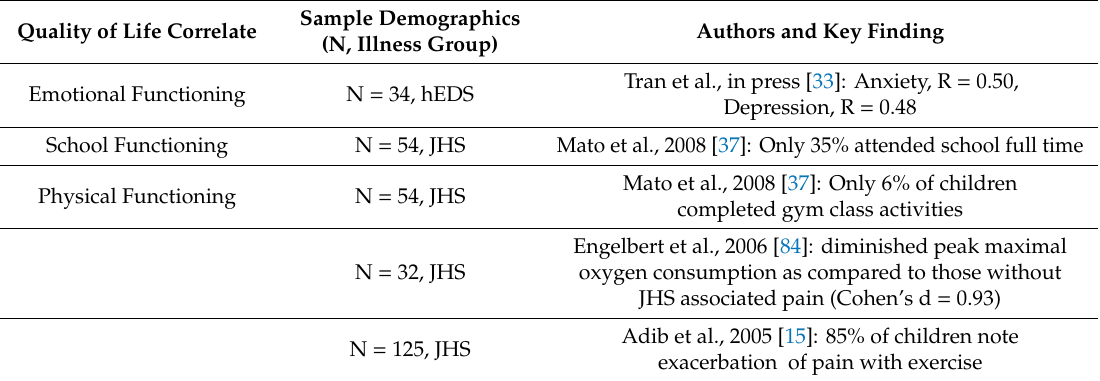
Table 2. Summary of Quality of Life Correlates of Pain in Pediatric Hypermobility